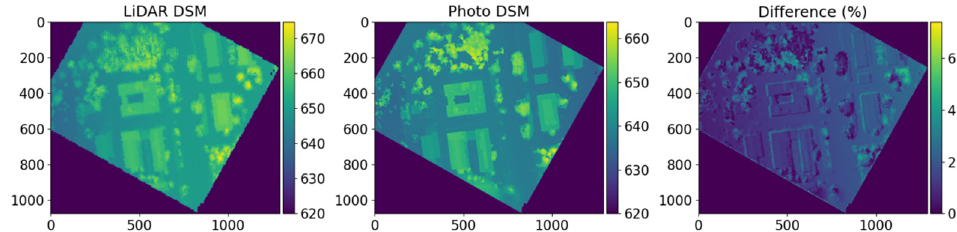
Figure 3. Comparison between the DSMs generated from LiDAR data and from photogrammetry.